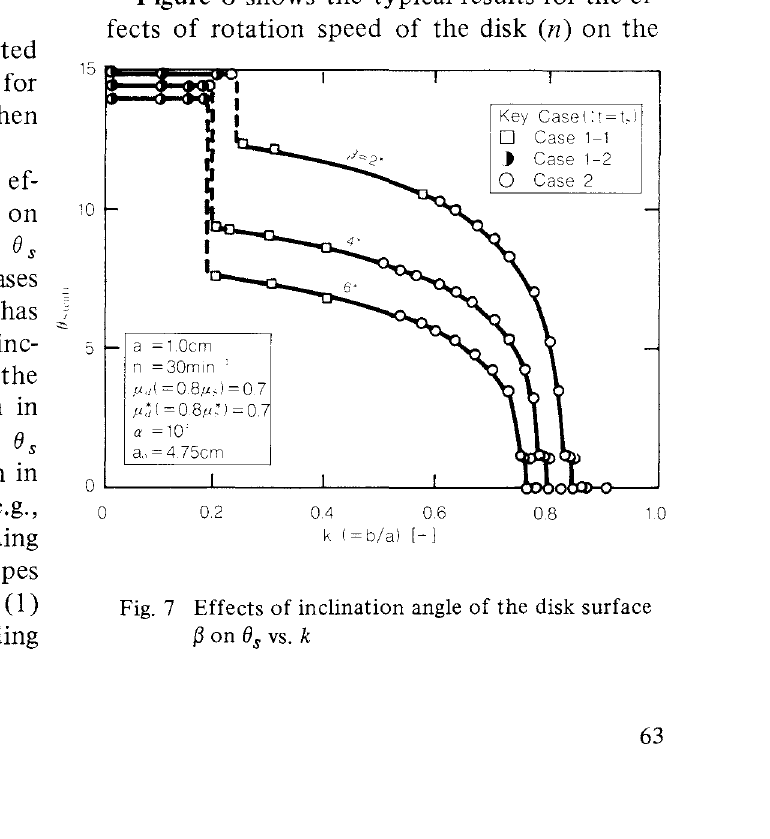
Fig. 7 Effects of inclination angle of the disk surface {3 On 8S VS.